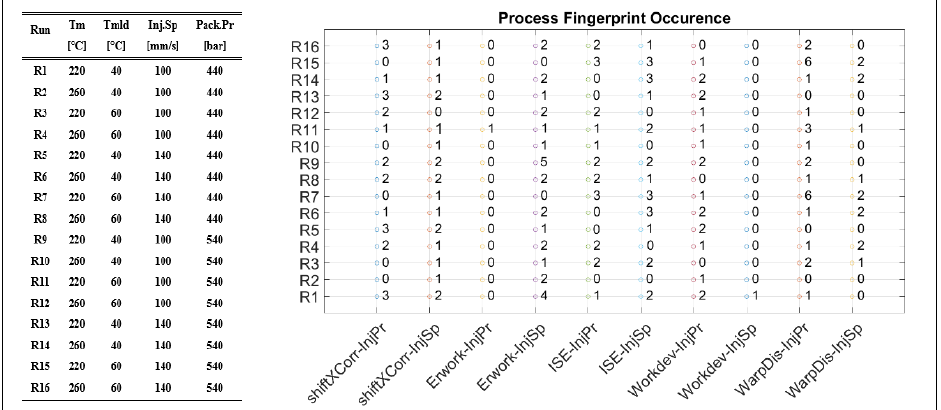
Figure 17. Process fingerprint candidate trend occurrence per Run.